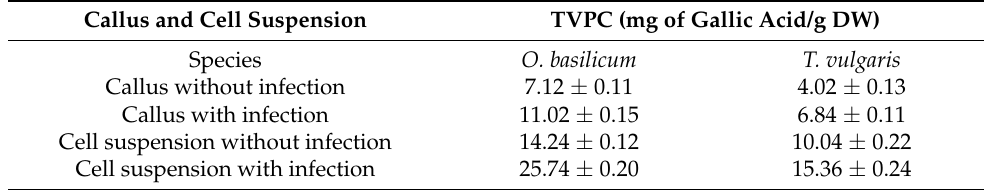
Table 1. Chemical content analyses from volatile extract in O. basilicum and T. vulgaris from callus and cell suspension with and without infection by V. dahliae.